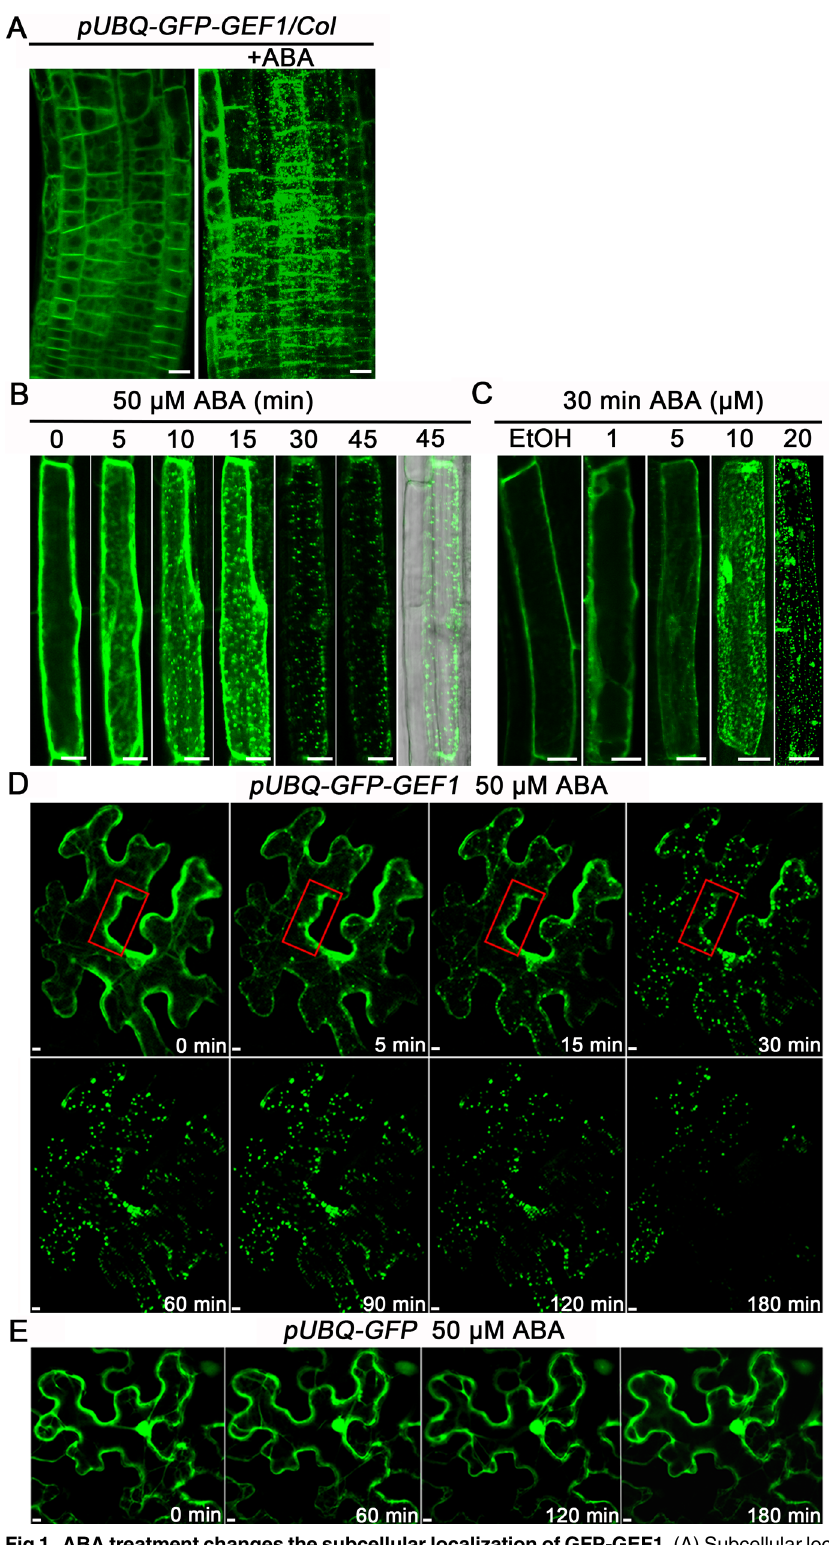
Fig 1. ABA treatment changes the subcellular localization of GFP-GEF1. (A) Subcellular localization of GFP-GEF1 in epidermal cells of the root elongation zone of Arabidopsis without ABA treatment (left) or